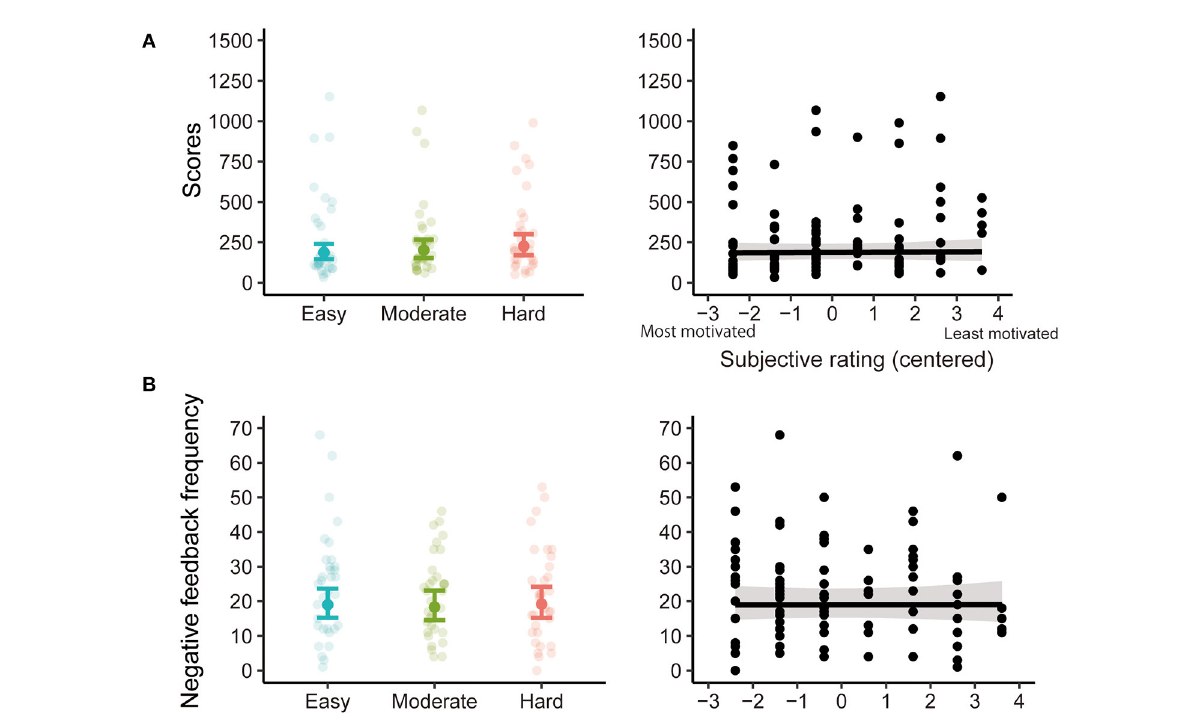
FIGURE5 The estimated coefficients of Goal (left) and the predicted values on Rating (right) in the (generalized) linear mixed-effects models [(G)LME] analyses for Scores (A) and Negative feedback frequency (B) . In Goal results, the filled dots and error bars represent the estimated coefficients and 95% confidence intervals. The transparent dots are data points for each participant. In Rating results, the black line represents the predicted values from the (G)LME, and the gray area represents the 95% confidence interval. Black dots are data points for each participant (number of participants × number of levels of goal scores).